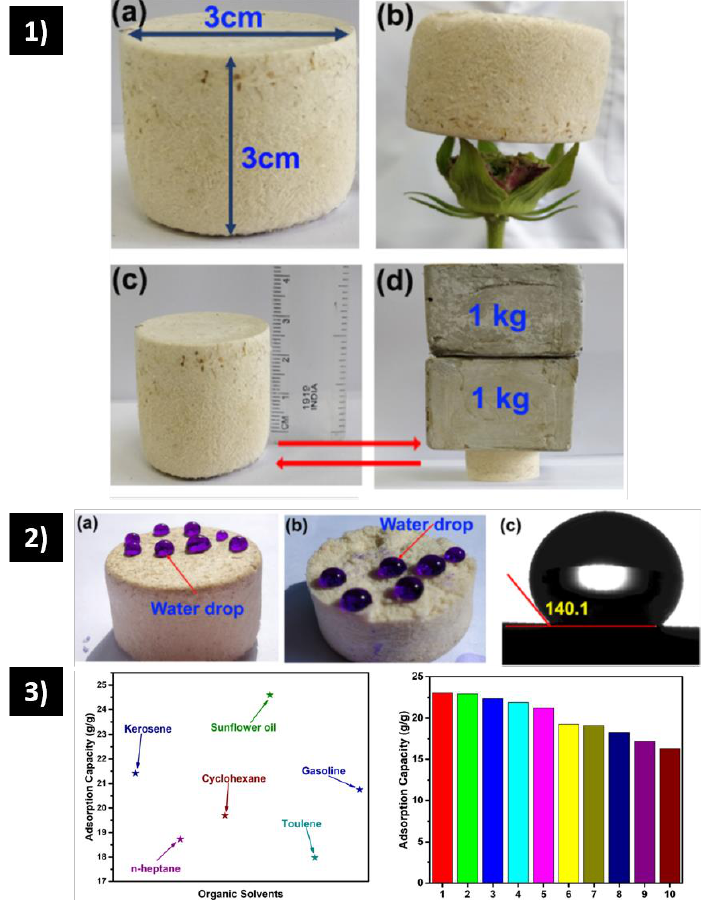
Figure 4. ( 1 ) Snapshots of bagasse fiber aerogel ( a ) macroscopic structure ( b ) standing on the petals of a flower ( c ) before compression ( d ) supported with 2 kg of weight. ( 2 ) Water droplets ( a ) on the surface of bagasse fibers aerogel ( b ) water droplets on the cross-sectionally cut of bagasse fibers aerogel ( c ) Water contact angle of bagasse fibers aerogel. ( 3 ) Various organic solvent adsorption capacities of SBA1. The adsorption capacity of SBA over ten regeneration cycles from the oil-water system [92].